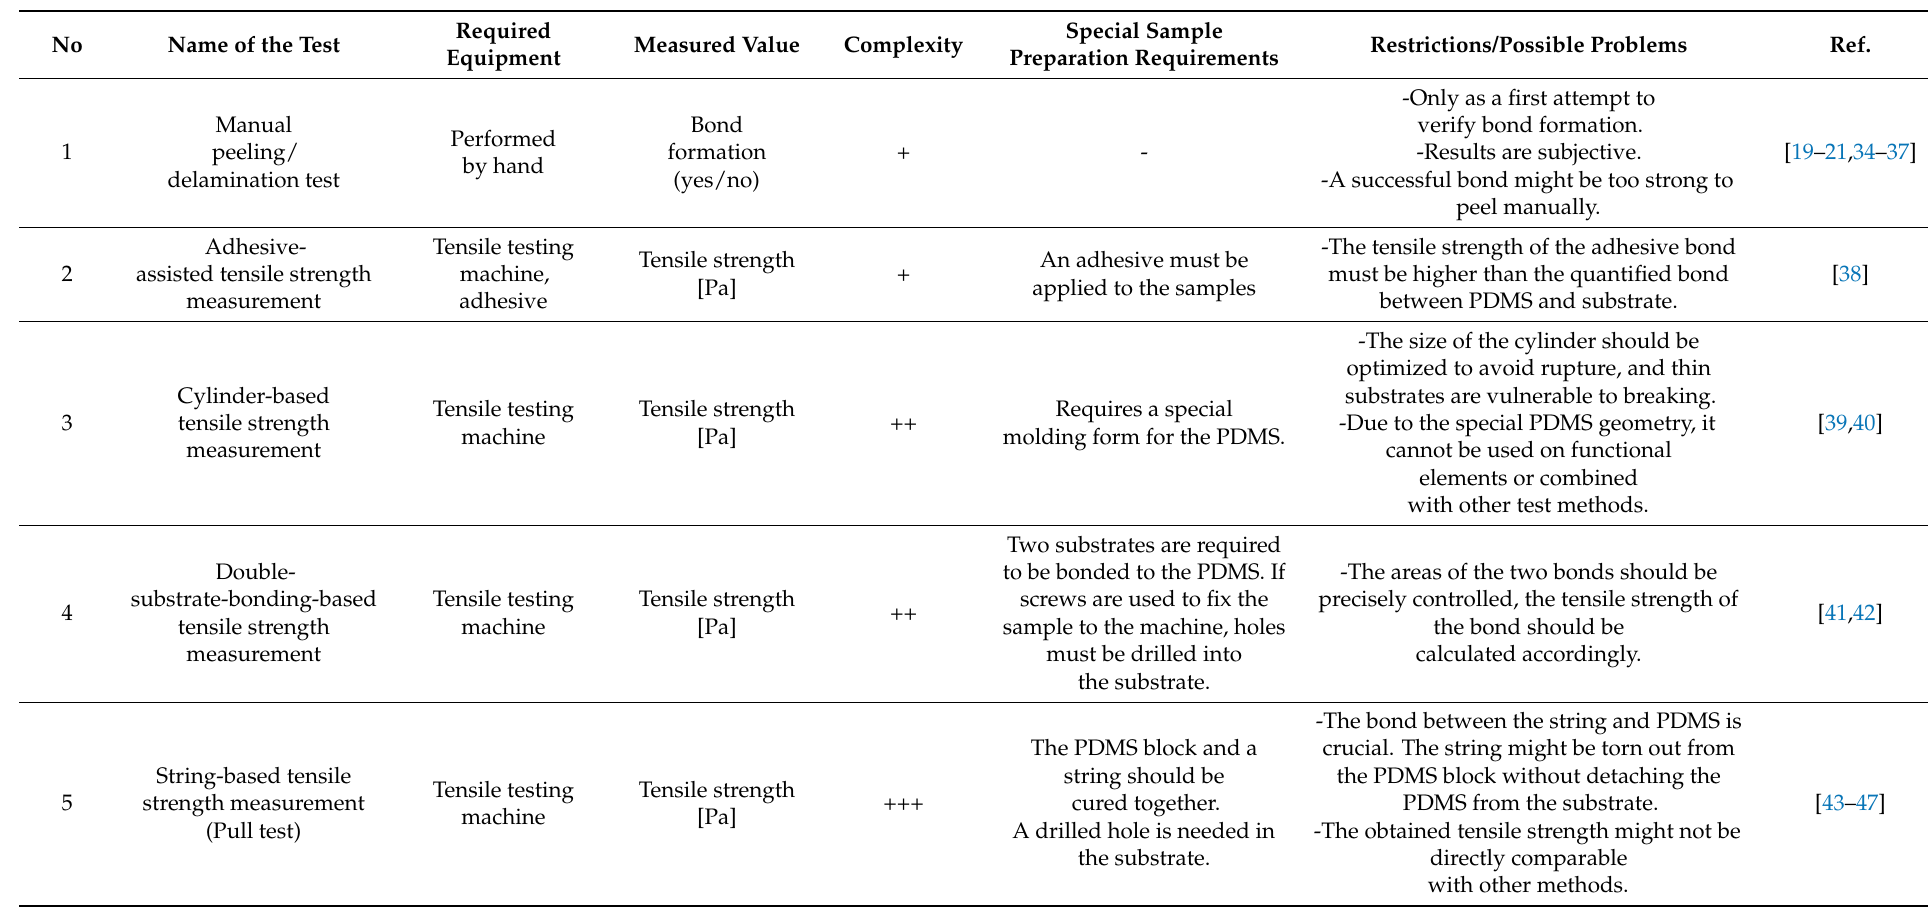
Table 1. The most frequently used bonding strength measurement methods and